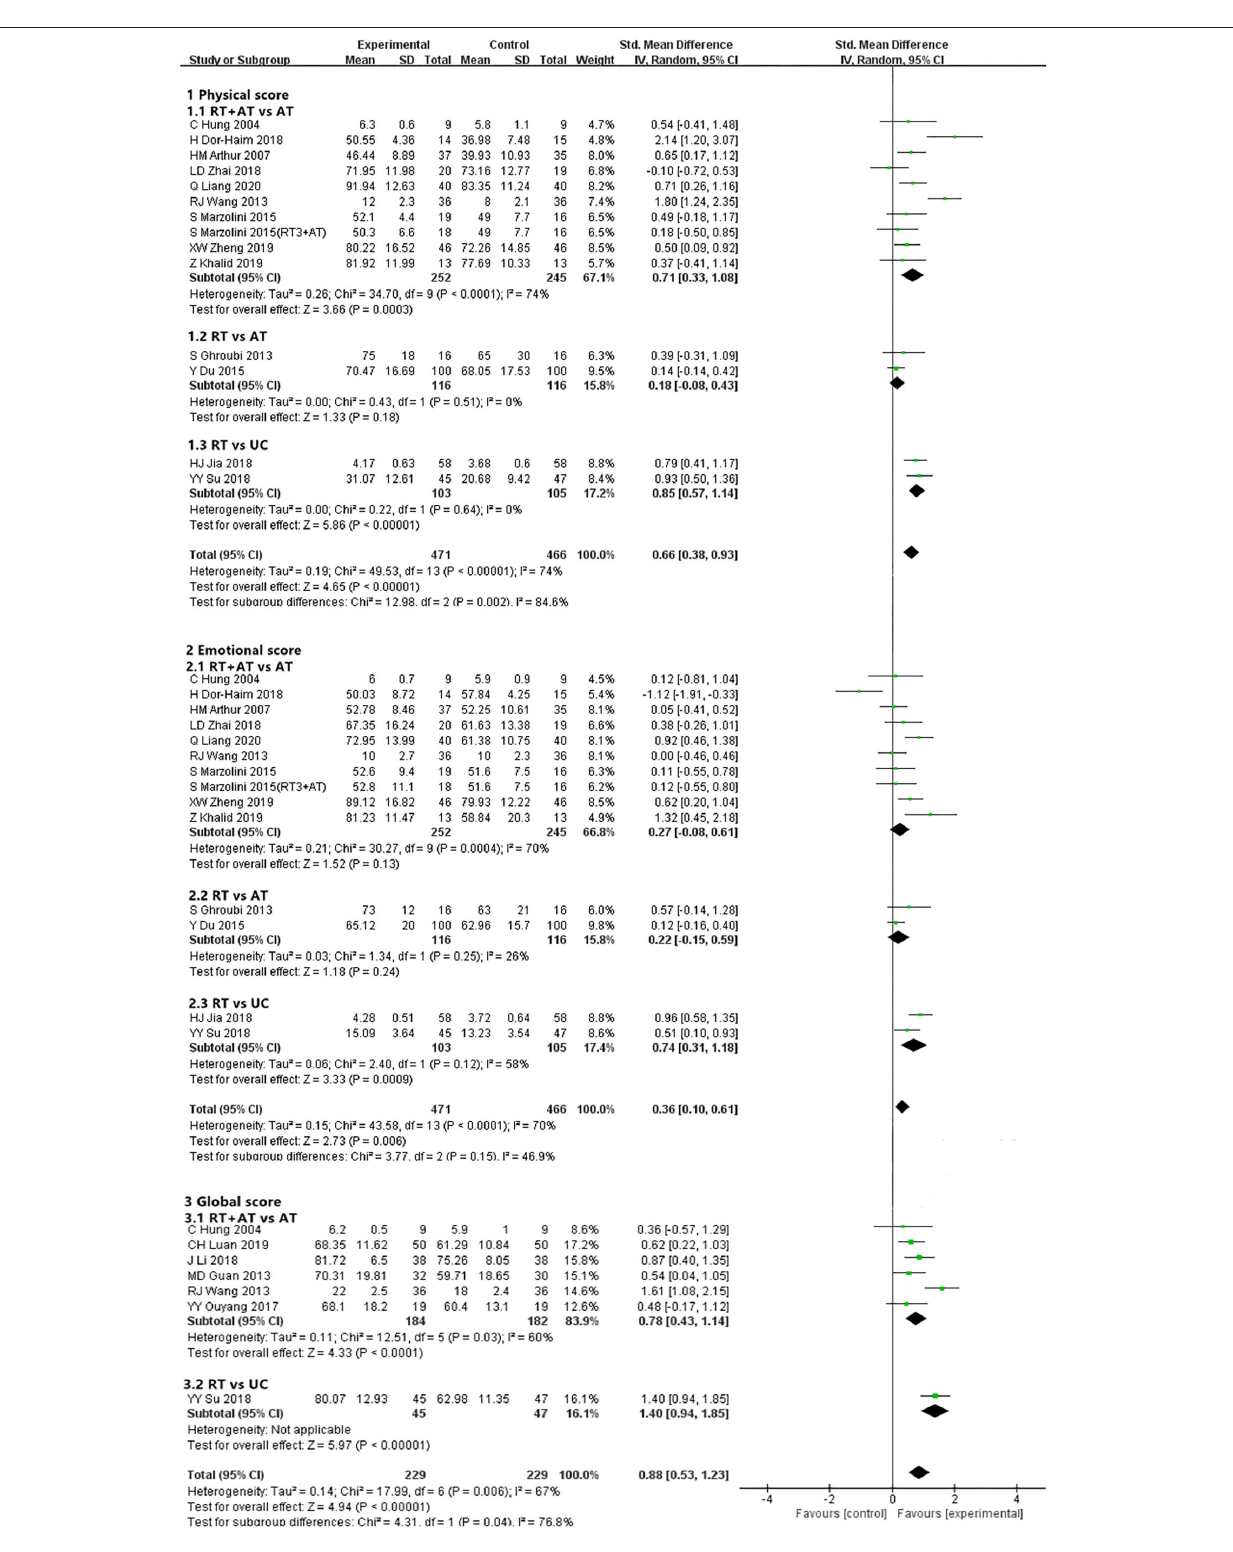
FIGURE 4 | Forest plot showing QOL of RT for